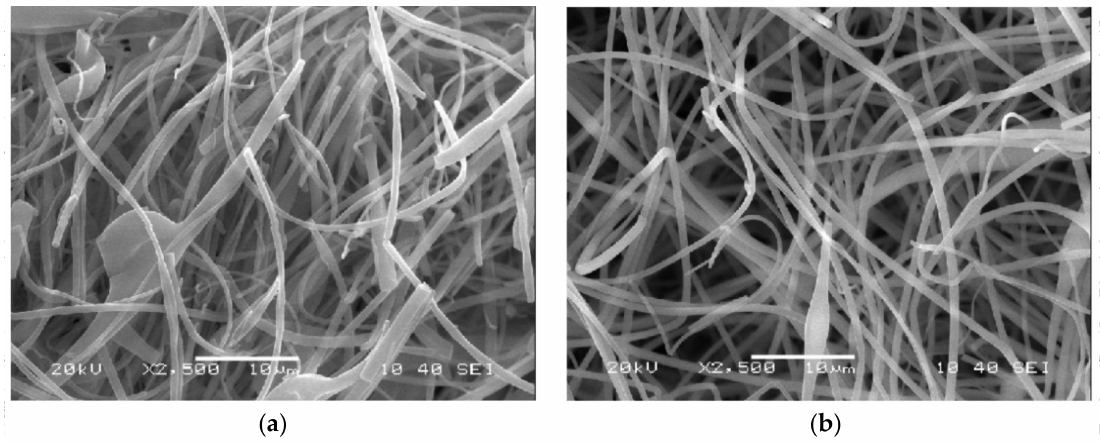
Figure 2. Scanning electron microscopic images of PVPVA64 + 1% CAR fibers prepared by high-speed electrospinning ( a ) and single-needle electrospinning ( b ).